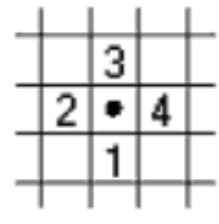
Figure 10. Neighbor pixel enumeration order.